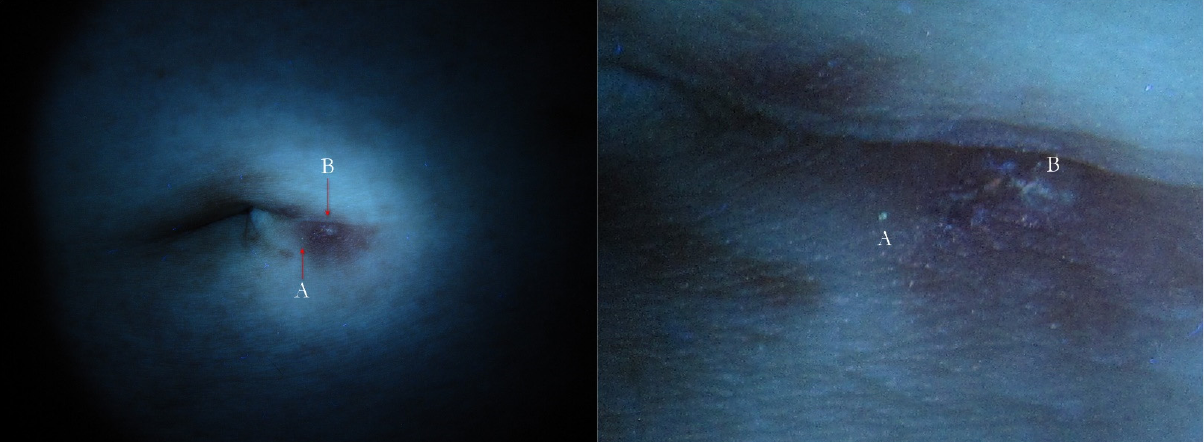
Figure 16. Surreptitious scabies. The same patient under UVA. The navel lesion shows too little signs ( left ) that in full ‐ frame view can be identified as a green dot (A) and a fuzzy white line (B), corresponding to Sarcoptes body and gallery remnants, respectively ( right ).